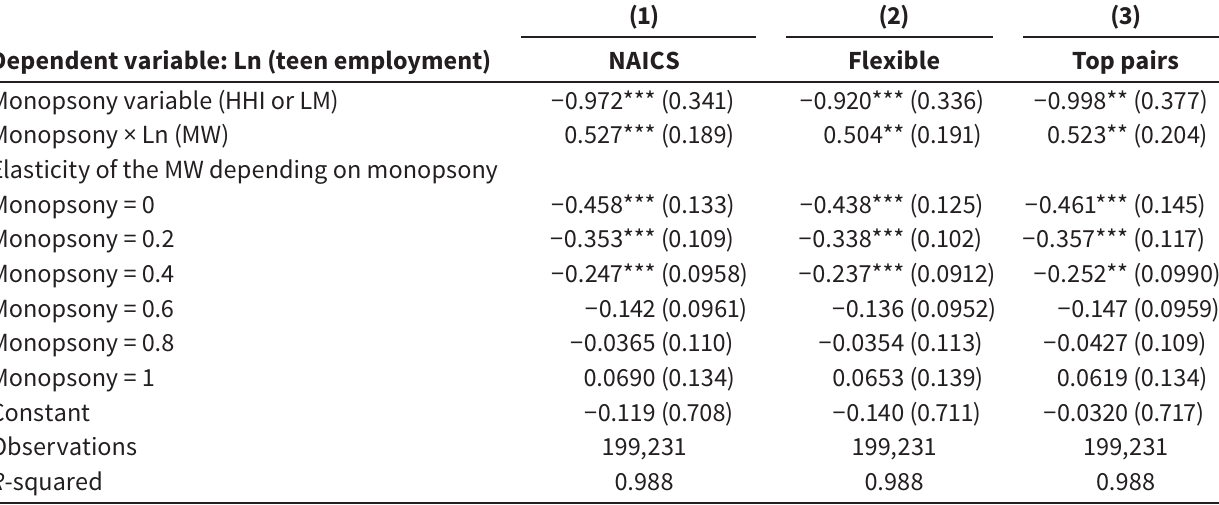
Robustness check: effects of the log of the MW interacted with all the classifications of clusters for the HHI on the log of teenage